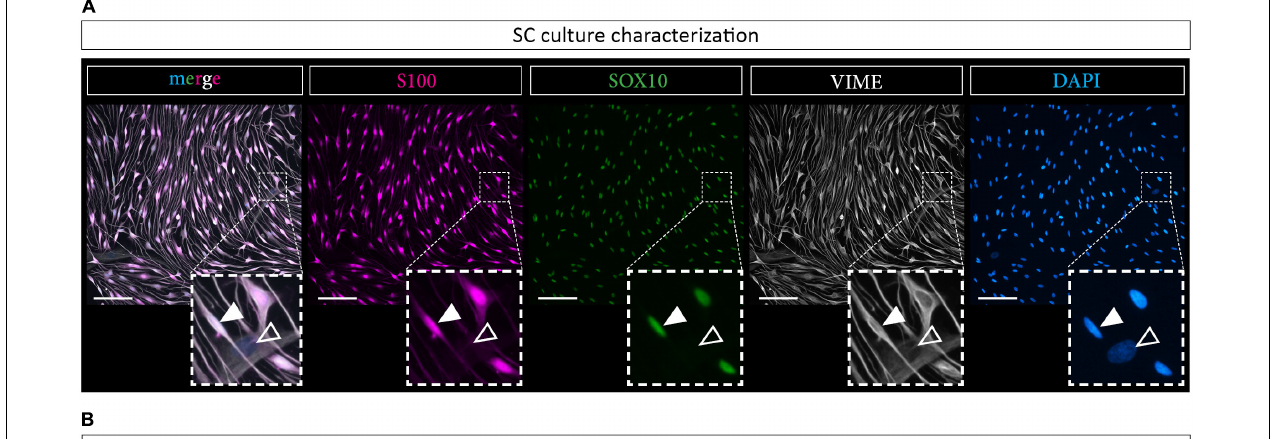
Frontiers in Cellular Neuroscience |